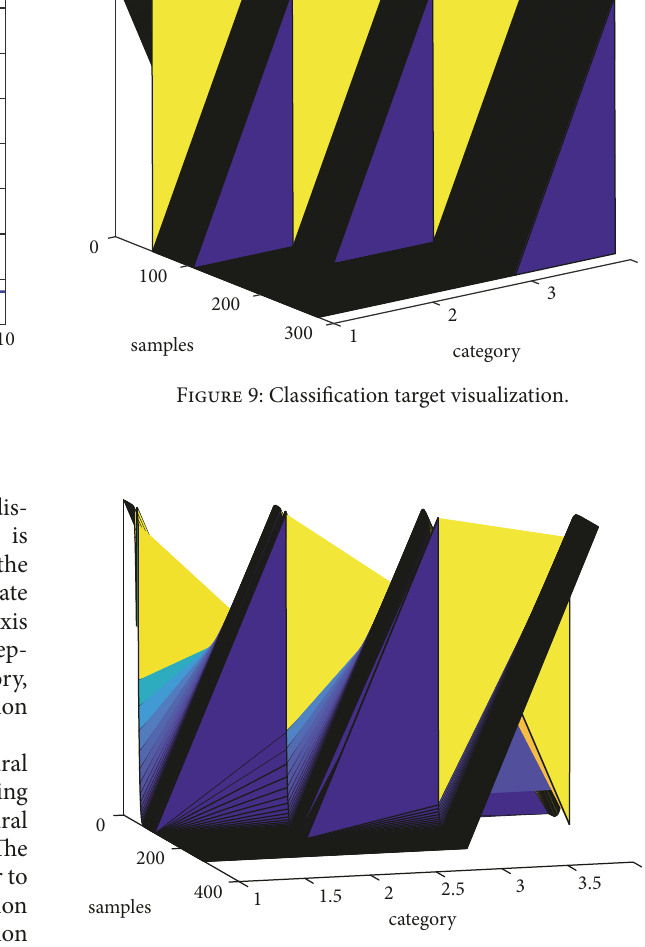
Figure 10: Contrast experiment with sparse coefficient